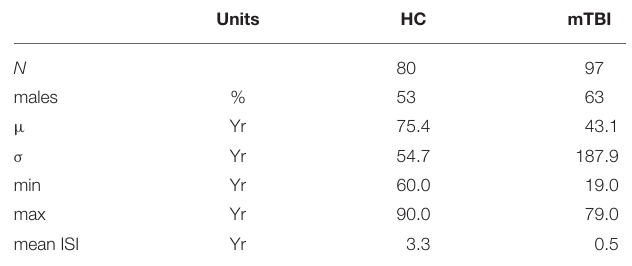
TABLE 1 | Age demographics of HC and mTBI